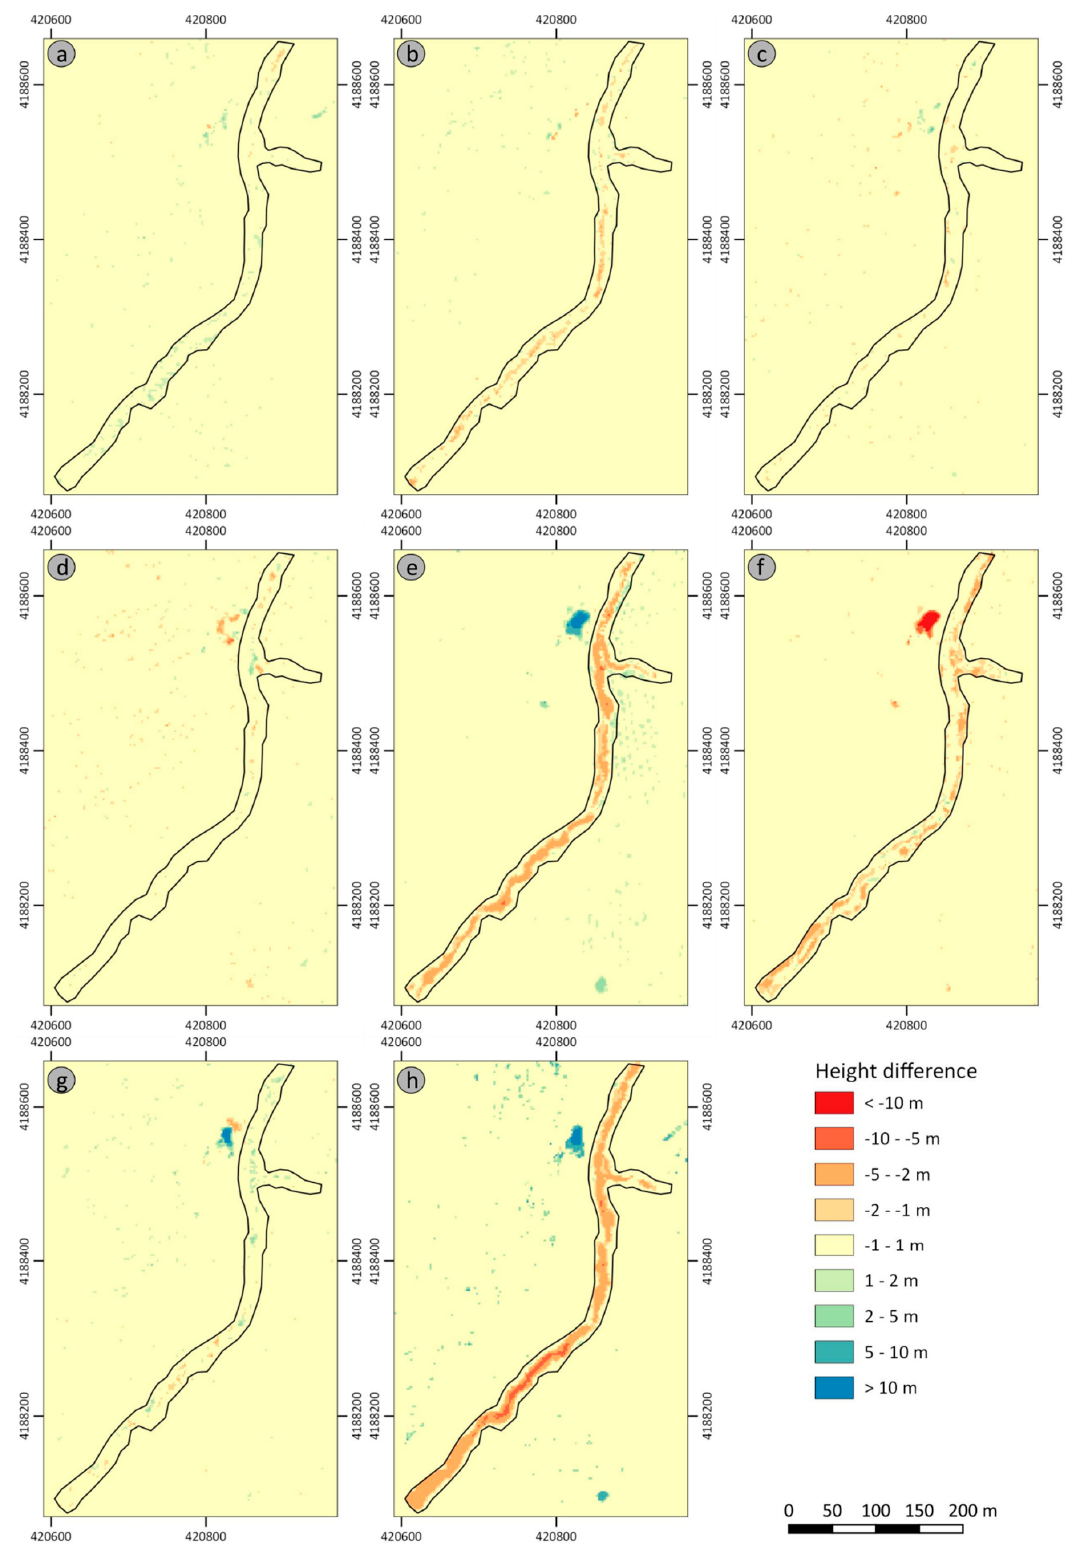
Figure 7. DSMs of differences (DoDs) of the detailed area: ( a ) period 1980–1996; ( b ) period 1996–2001; ( c ) period 2001–2005; ( d ) period 2005–2009; ( e ) period 2009–2011; ( f ) period 2011–2013; ( g ) period 2013–2016; ( h ) complete period (1980–2016).